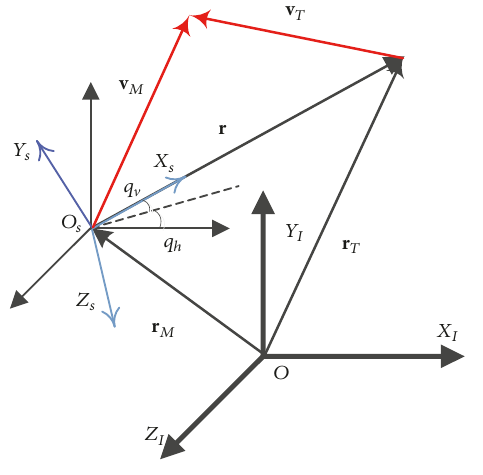
Figure 1: Engagement